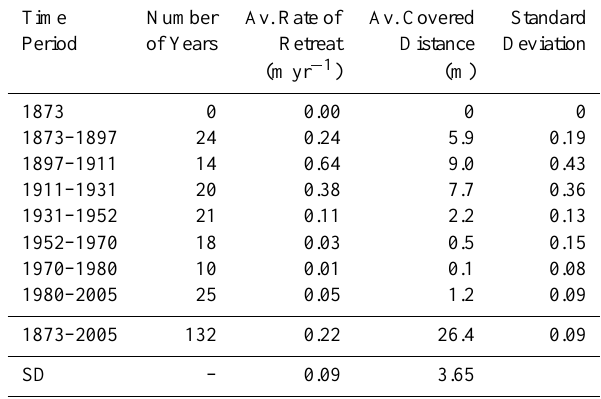
Table 2. Shoreline retreat rates and average covered distances for different time periods.